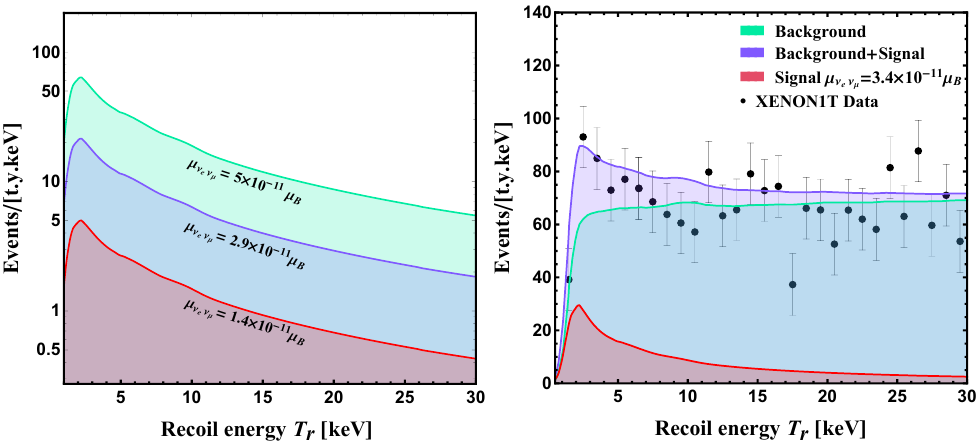
Figure 1 . Number of electron recoil events as a function of the recoil energy. Left: green, blue and orange shaded region indicate the signals corresponding to the neutrino magnetic moment (cid:22) (cid:23) = 5 (cid:2) 10 (cid:0) 11 (cid:22) B ; 2 : 9 (cid:2) 10 (cid:0) 11 (cid:22) B and 1 : 4 (cid:2) 10 (cid:0) 11 (cid:22) B respectively. Right: signal spectrum in e (cid:23) (cid:22) presence of single component neutrino transition magnetic moment (cid:22) (cid:23) XENON1T experimental data [1] and background spectrum are also